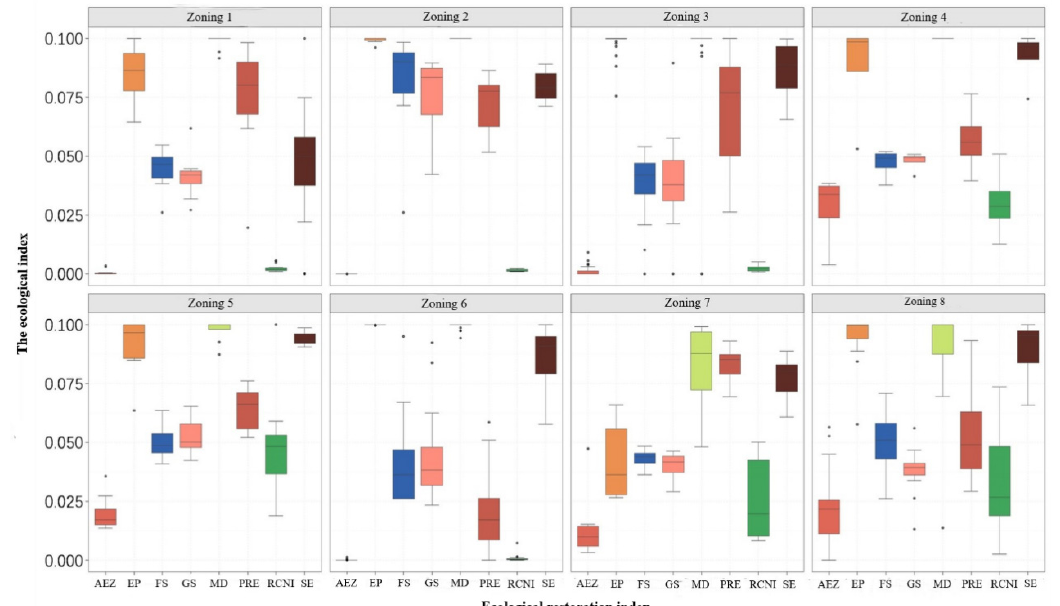
Figure 7. Ecological indicators of different ecological restoration zones of the Qilian Mountains. “AEZ” represents the agricultural production potential; “EP” represents extreme precipitation; “FS” represents the interannual change rate of the normalized difference vegetation index (NDVI) in forestry areas’ vegetation; “Rural per capita income” represents regional GDP; “GS” represents the NDVI interannual change rate of grassland vegetation; “MD” represents the mine distribution density; “PRE” represents the total annual precipitation; “SE” represents the soil erosion volume; Zoning 1 represents the headwaters of the Datong River Basin; Zoning 2 represents the Danghe-Dahaerteng River Basin; Zoning 3 represents Aksay (corridor region of the western Hexi Basin); Zoning 4 represents the Oasis Agricultural Area at the northern foothills of Qilian Mountain; Zoning 5 represents the northern confluence area of the Qinghai Lake; Zoning 6 represents the upper Shule River to middle Heihe River; Zoning 7 represents the Huangshui Basin Valley; and Zoning 8 represents the northeastern Tsaidam